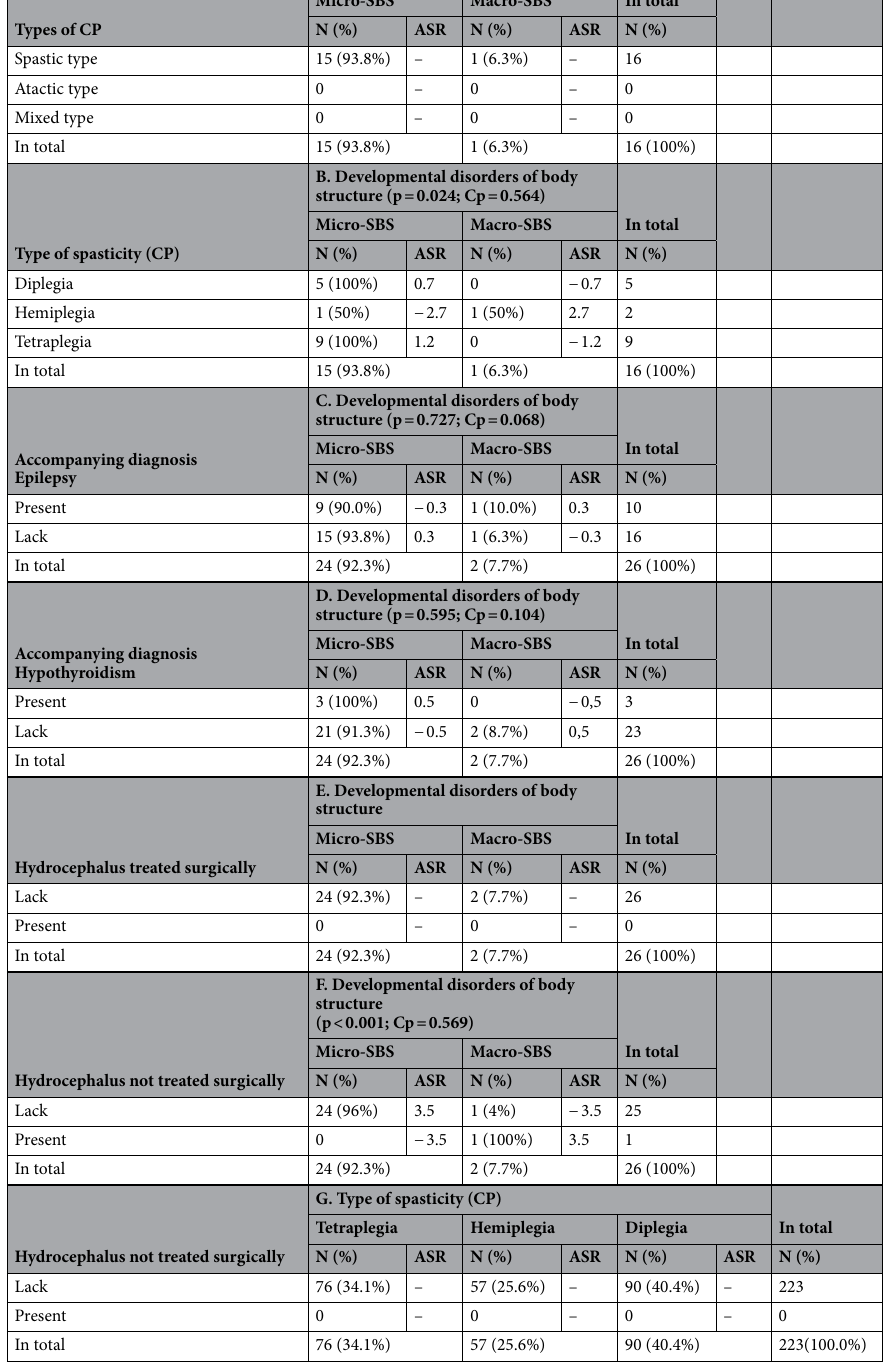
Table 3. Developmental disorders of body structure and: type of CP (A), type of spasticity (CP) (B), epilepsy (C), hypothyroidism (D), hydrocephalus treated/not treated surgically (E/F), type of spasticity (CP) and hydrocephalus not treated surgically (G). CP cerebral palsy, micro-SBS microsomic body structure, macro-SBS macrosomic body structure, N numbers of patients, % percent, p probability value calculated by chi-square test of independence, Cp Pearson’s Contingency Coefficient C ,Cp ≥ 0, values distant from 0 reflect a relationship; values approaching 1 correspond to a near-perfect association, ASR Adjusted Standardized Residuals, values > 1.96 reflect a higher number, and those below < − 1.96 correspond to a lower number than a random